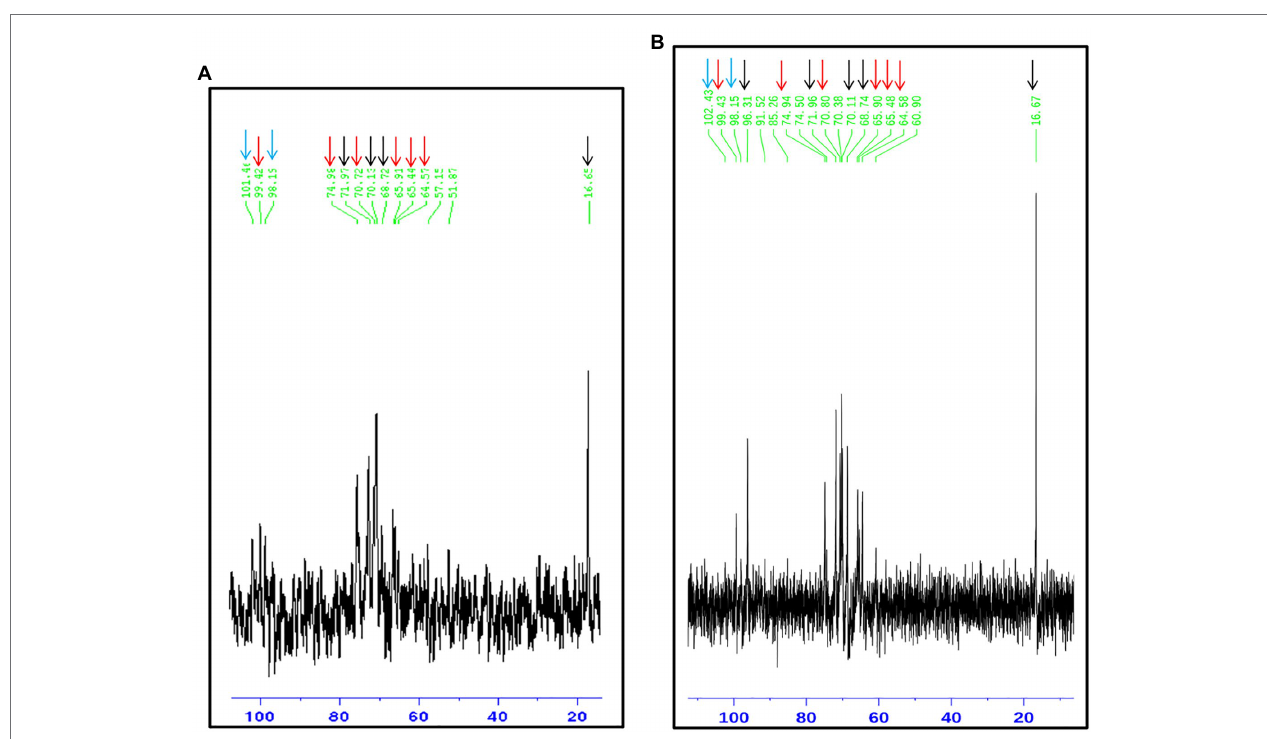
FIGURE 4 | 13 C-NMR of the rhamnomannan fraction isolated from the strains presenting less virulence in yeast phase. Sporothrix schenckii 4822 (A) and S. brasiliensis 4824 (B) show the signals associated to type I rhamnomannan (red and black arrows), but also a signal corresponding to C-1 of α -L-Rhap nonreducing end unit of α -L-Rhap-(l, 2)- α —Rhap and 2,4-di-0-substituted α -D-mannopyranose units (Cian arrows; Travassos, 1985), which suggest longer side chains in the cell wall for these two